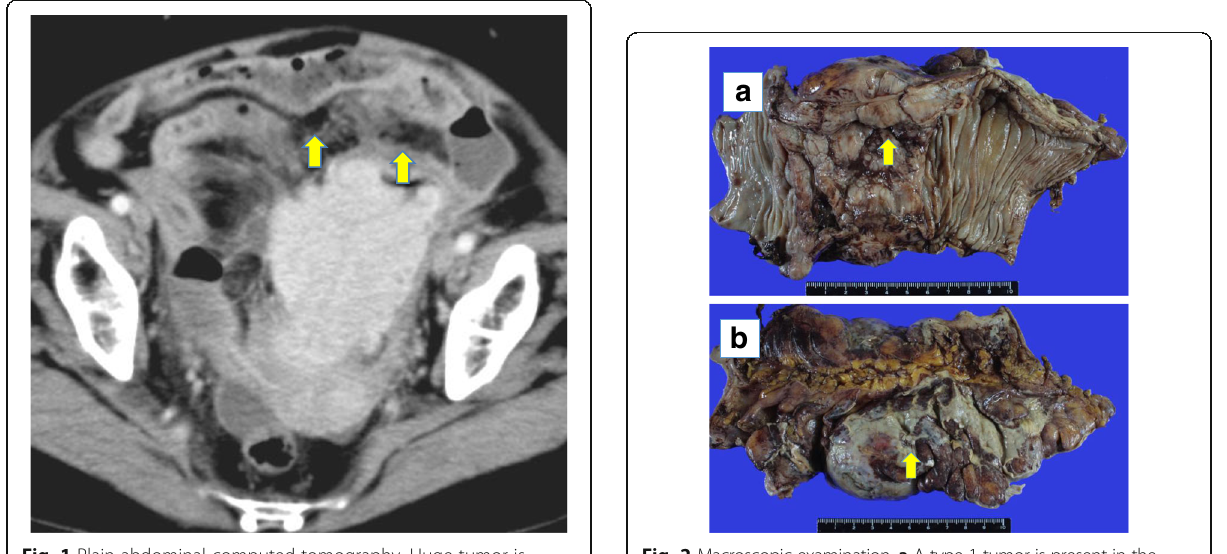
Fig. 2 Macroscopic examination. a A type 1 tumor is present in the sigmoid colon. b The sigmoid colon is surrounded by contamination. Arrows indicate concavity suspected the site of perforation of the